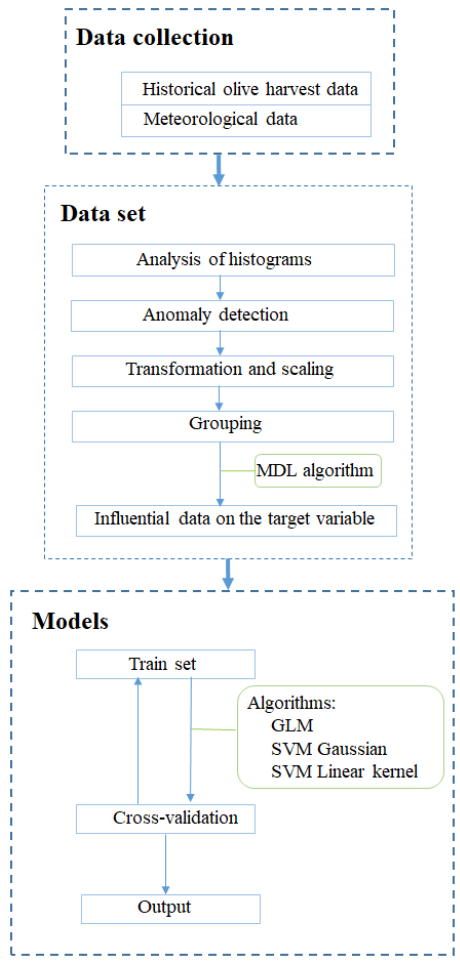
Figure 3. Flow diagram of the methodology.